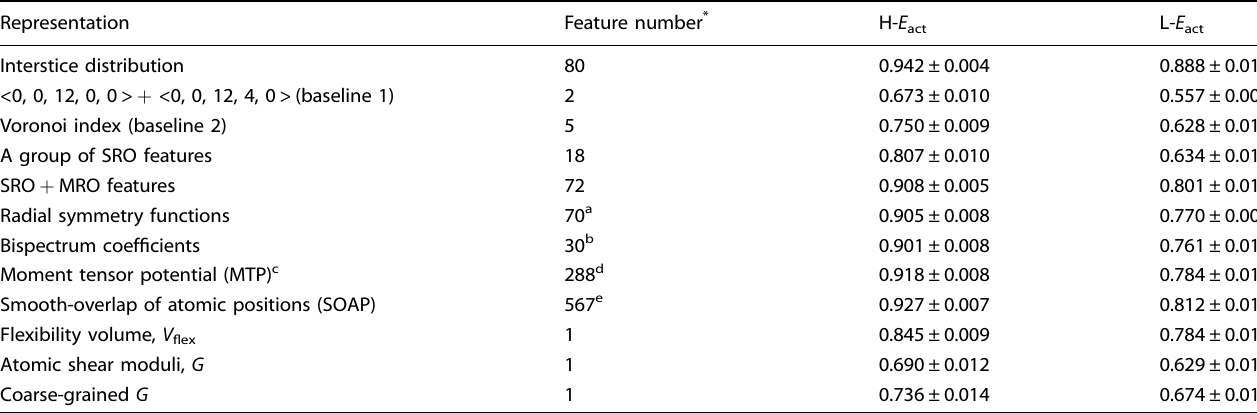
Table 1. Using various pure structural representations or physical signatures to classify the highest 5% (denoted as H- E act problem) and lowest 5% E act atoms (L- E act problem) of the combined E act spectrum merged from six MGs (Fig.